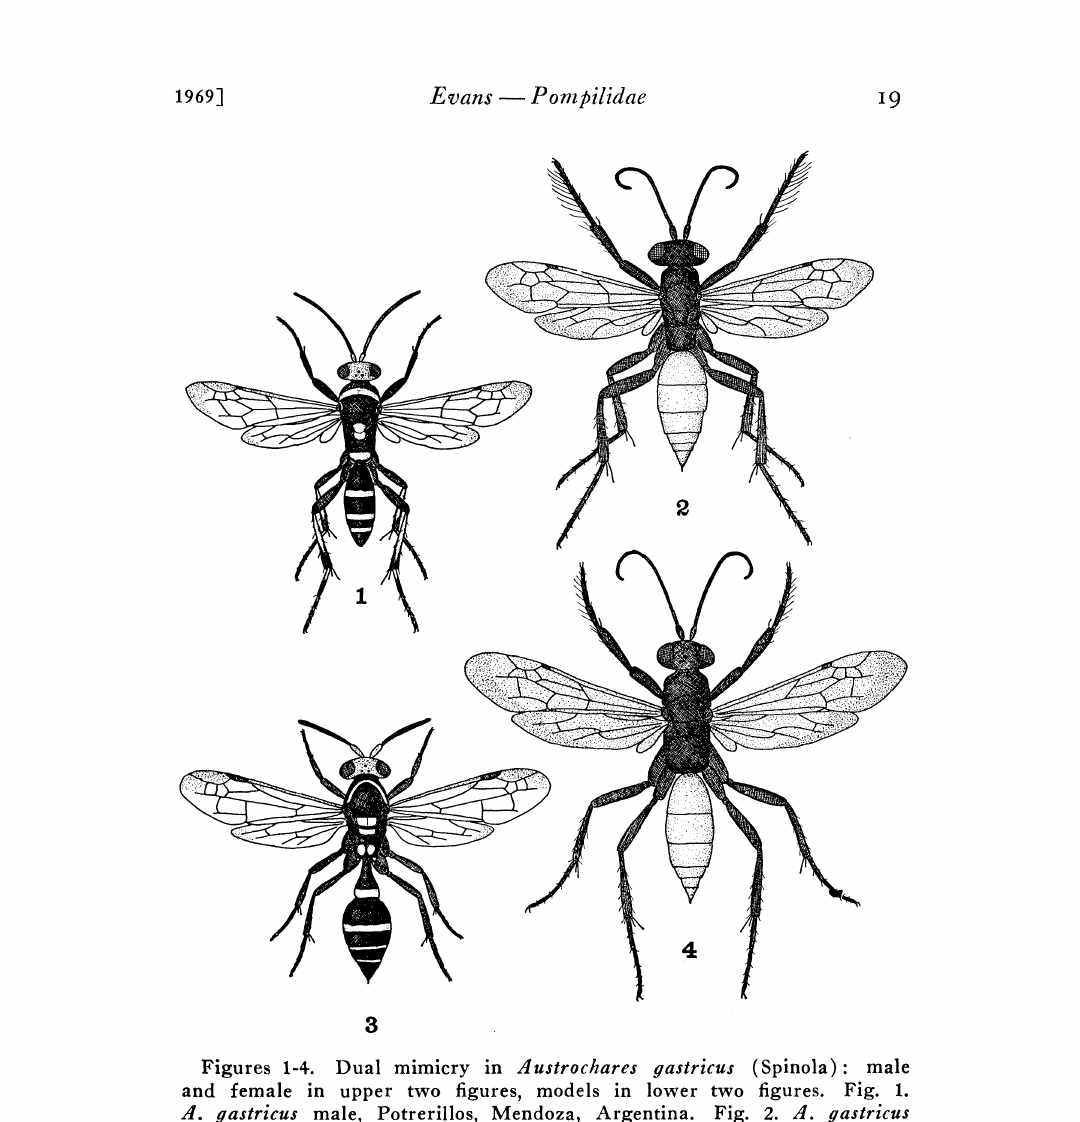
Figures 1-4. Dual mimicry in 2/ustrochares gastricus (Spinola) male and female in upper two figures, models in lower two figures. Fig. 1. .4. gastricus male, Potrerillos, Mendoza, Argentina. Fig. 2. 2/. gastricus female, same locality. Fig. 3. Polybia lar,ula ruficels Sehrottky (Vespidae), female, La Rioja, Argentina. Fig. 4. Dicranollius satanus (Holmberg) (Pompilidae), female, Caeheuta, Mendoza,